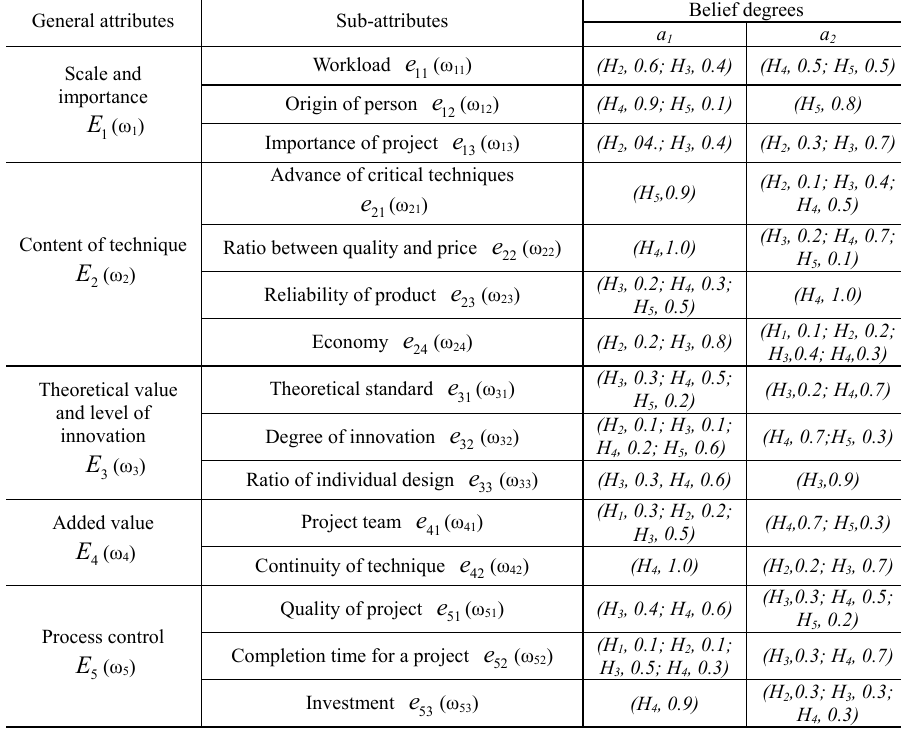
Table 2. Generalized decision matrix for product assessment and belief degrees of